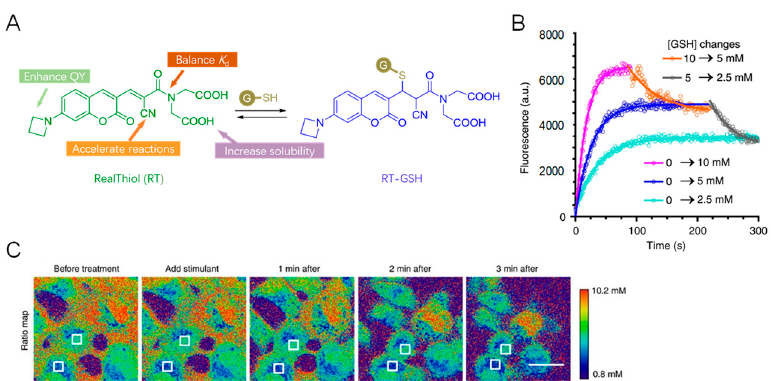
Figure 14. ( A ) The reversible response mechanism of RT to GSH. ( B ) Dynamic and reversible monitoring of GSH level changes by RT. ( C ) Ratiometric imaging of dynamic GSH changes during ferroptosis induced by erastin in HT − 1080 cells. Reprinted/adapted with permission from Ref. [70]. Copyright 2017, The Authors.